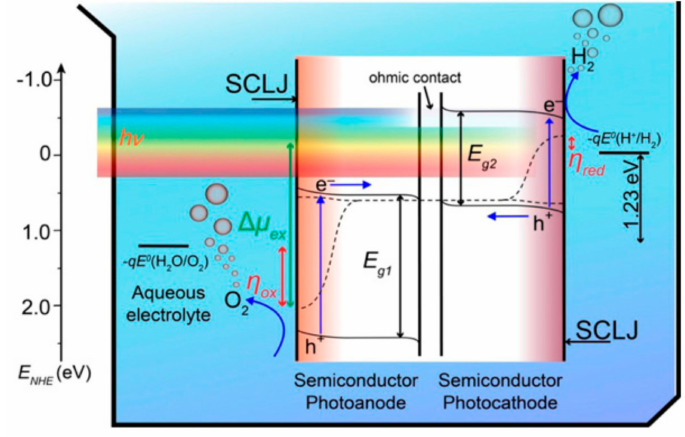
Figure 2. Schematic illustration depicting the mechanism of PEC water splitting in a tandem cell. Produced with the permission of ref. [24]. Copyright 2013, American Chemical Society.